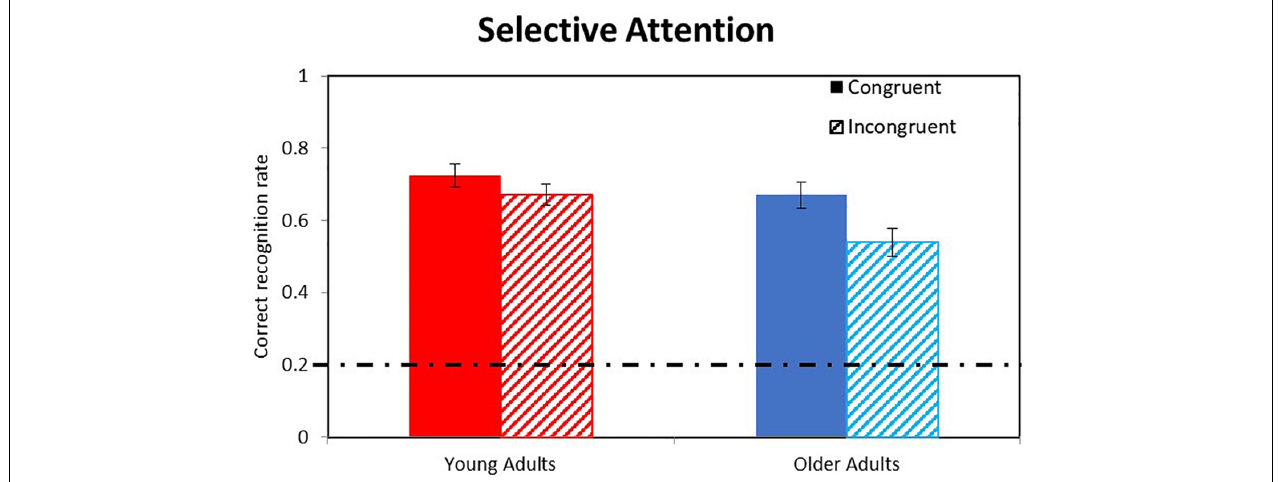
FIGURE 3 | Analysis of Selective Attention effects. Bars indicate correct recognition rates for congruent (full) vs. incongruent (dashed) sentences in young (red) and older (blue) adults averaged across different SNRs. Error bars indicate 95% CI of their respective means (MLM estimates). The dashed-and-dot horizontal line indicates the chance level